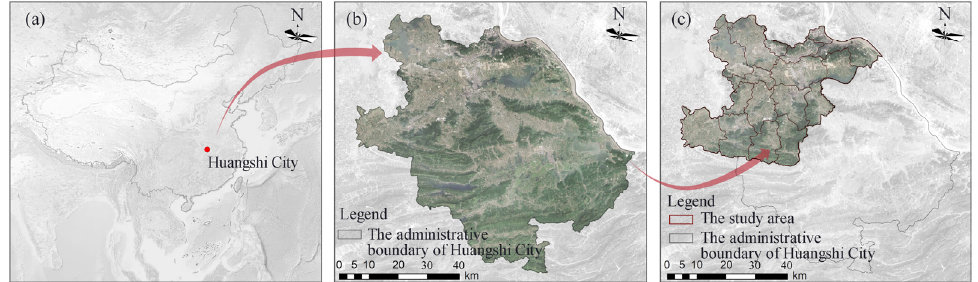
Figure 1. Location of Huangshi City ( a ), the administrative boundary of Huangshi City ( b ), and the study area ( c ).